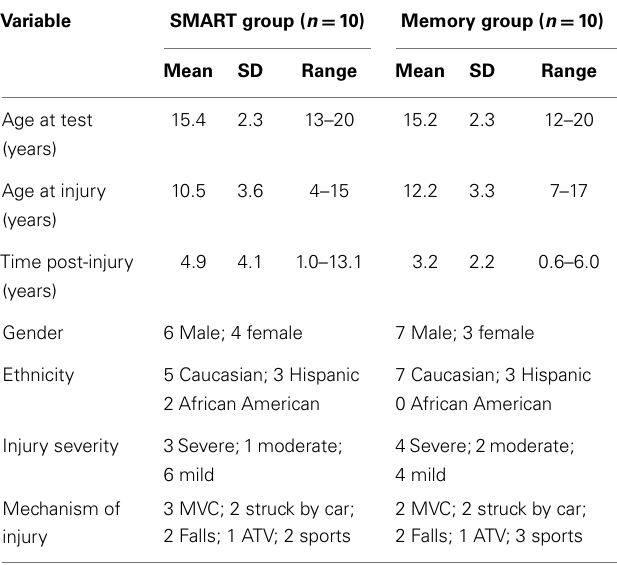
Table 1 | Demographic and injury characteristics of study participants